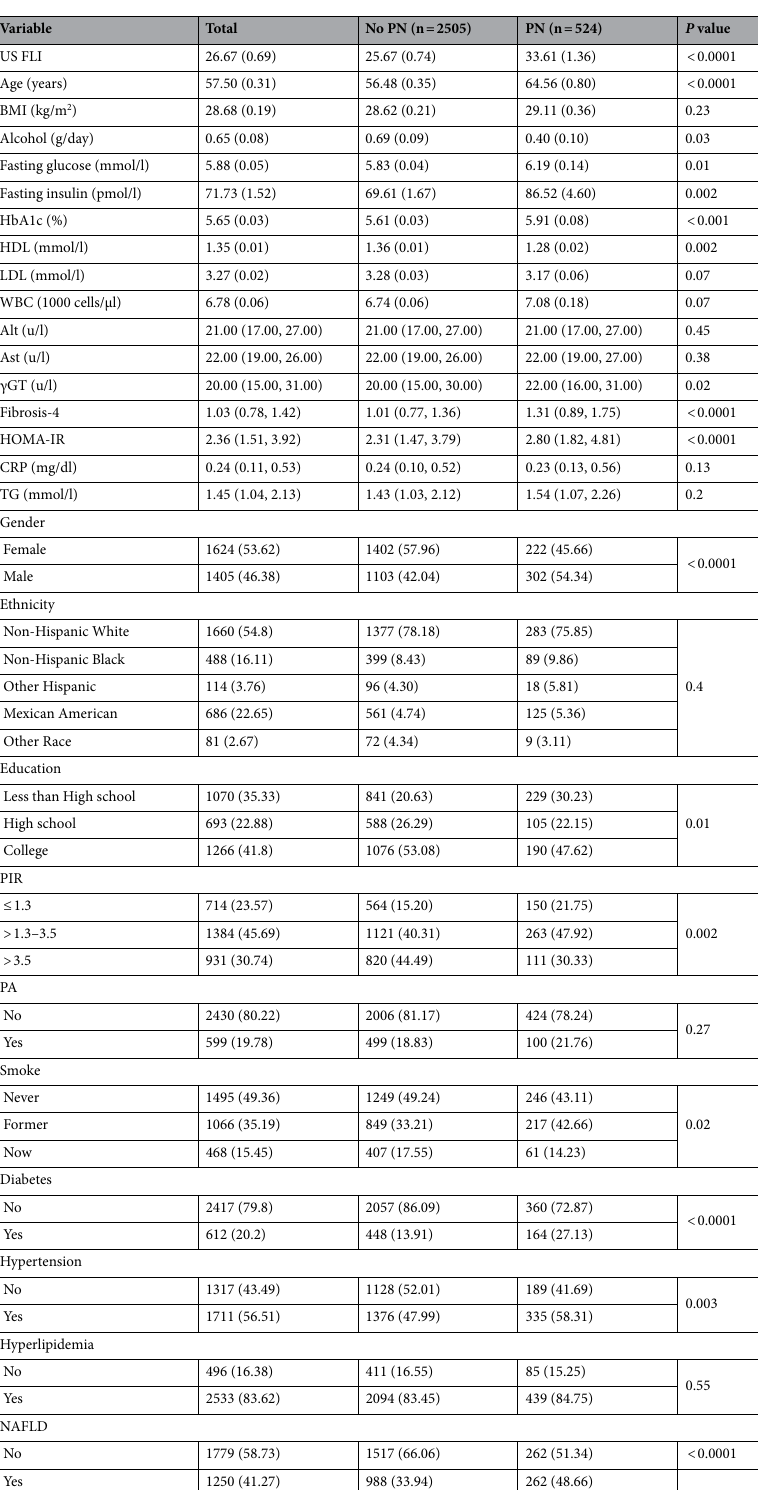
Table 1. Baseline characteristics of adult stratified by PN status. PN peripheral neuropathy, US FLI U.S. Fatty Liver Index, BMI body mass index, HbA1C glycosylated hemoglobin A1C, HDL high-density lipoprotein, LDL low density lipoprotein, WBC white blood cell, Alt alanine transaminase, Ast aspartate transaminase, γGT gamma glutamyl transferase, HOMA-IR homeostasis model assessment of insulin resistance, CRP C-reactive protein, TG triglyceride, PIR poverty income ratio, PA physical activity, NAFLD non-alcoholic fatty liver